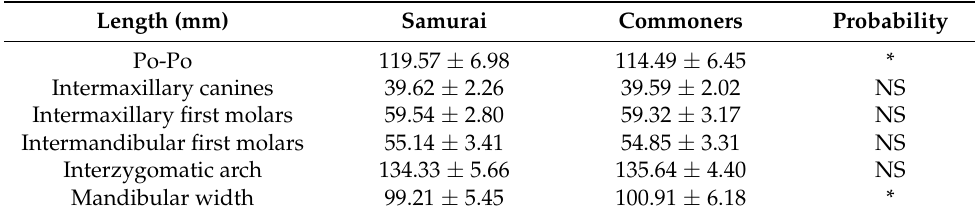
Table 4. Comparison of maxillary and mandibular width between samurai and commoners.